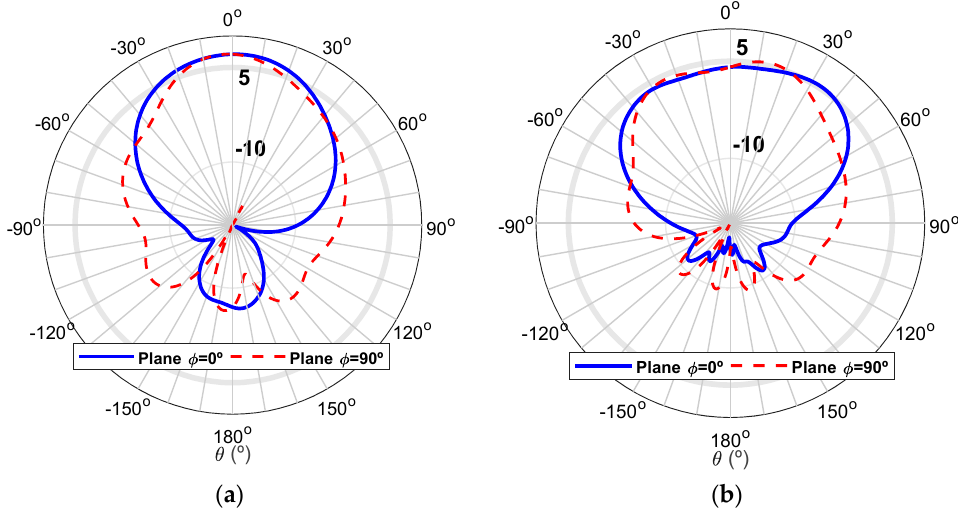
Figure 6. Simulated radiation pattern of the individual patch antenna in the two main radiation planes, for both states of the PIN diode: ( a ) ON mode (20 GHz) and ( b ) OFF mode (29 GHz).